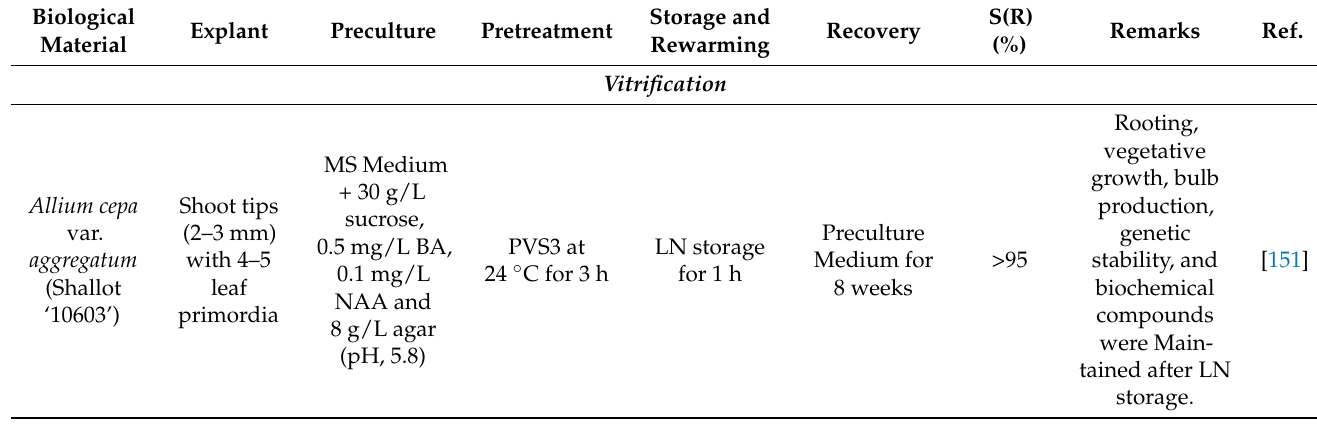
Table 4. Recently developed cryopreservation protocols of selected crops of agronomic